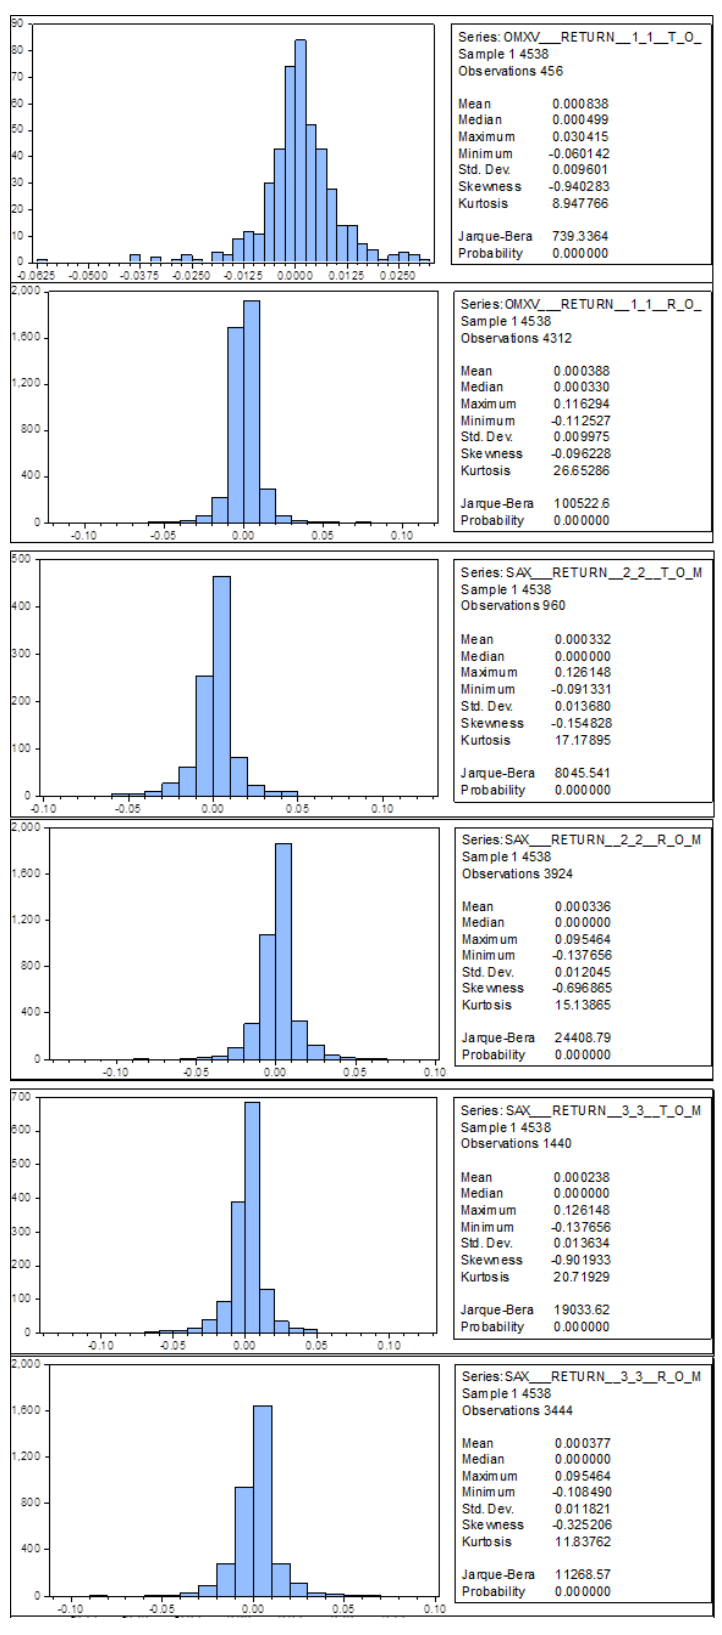
Figure A2. Histograms and descriptive statistics for data samples with lowest difference between average T-o-M and R-o-M returns References.